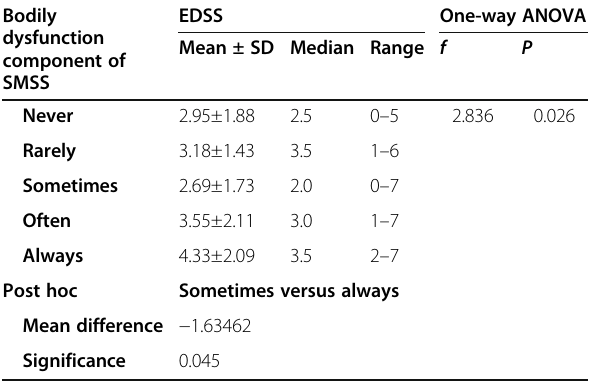
Table 8 Comparison of MSNQ scores in the cognitive and psychological impairment component of